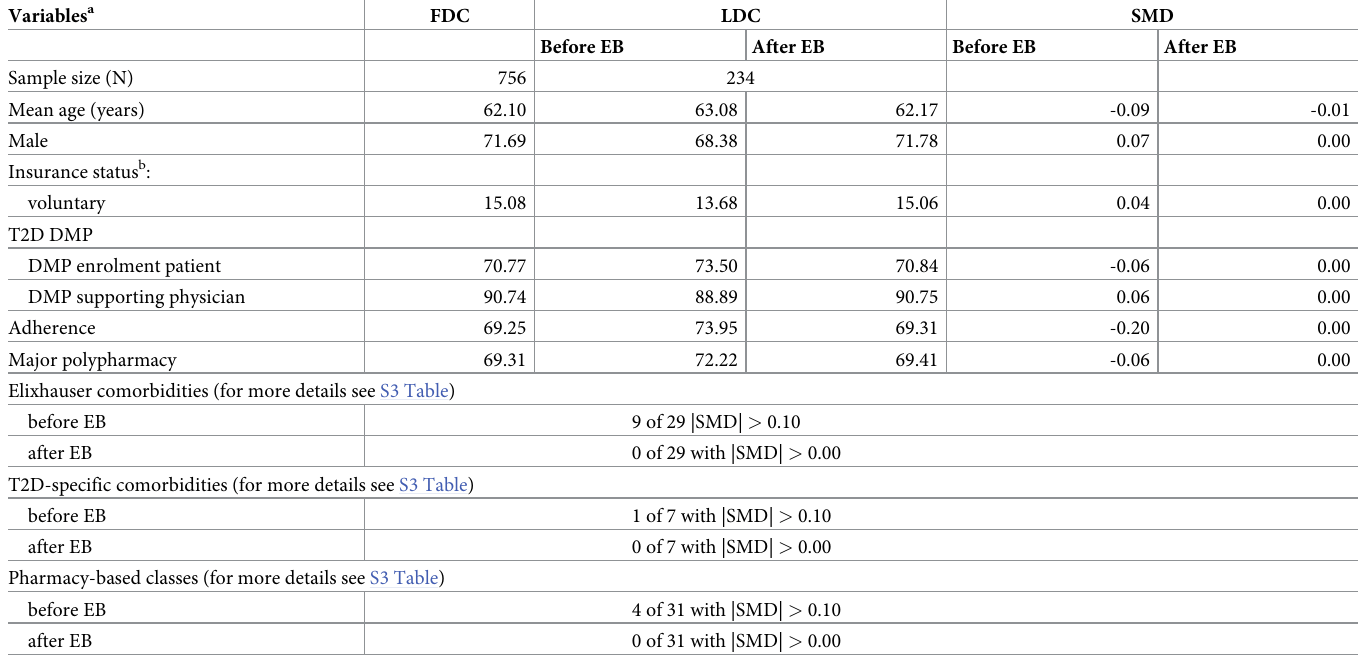
Table 1. Baseline characteristics of fixed-dose and loose-dose combination cohorts before and after entropy